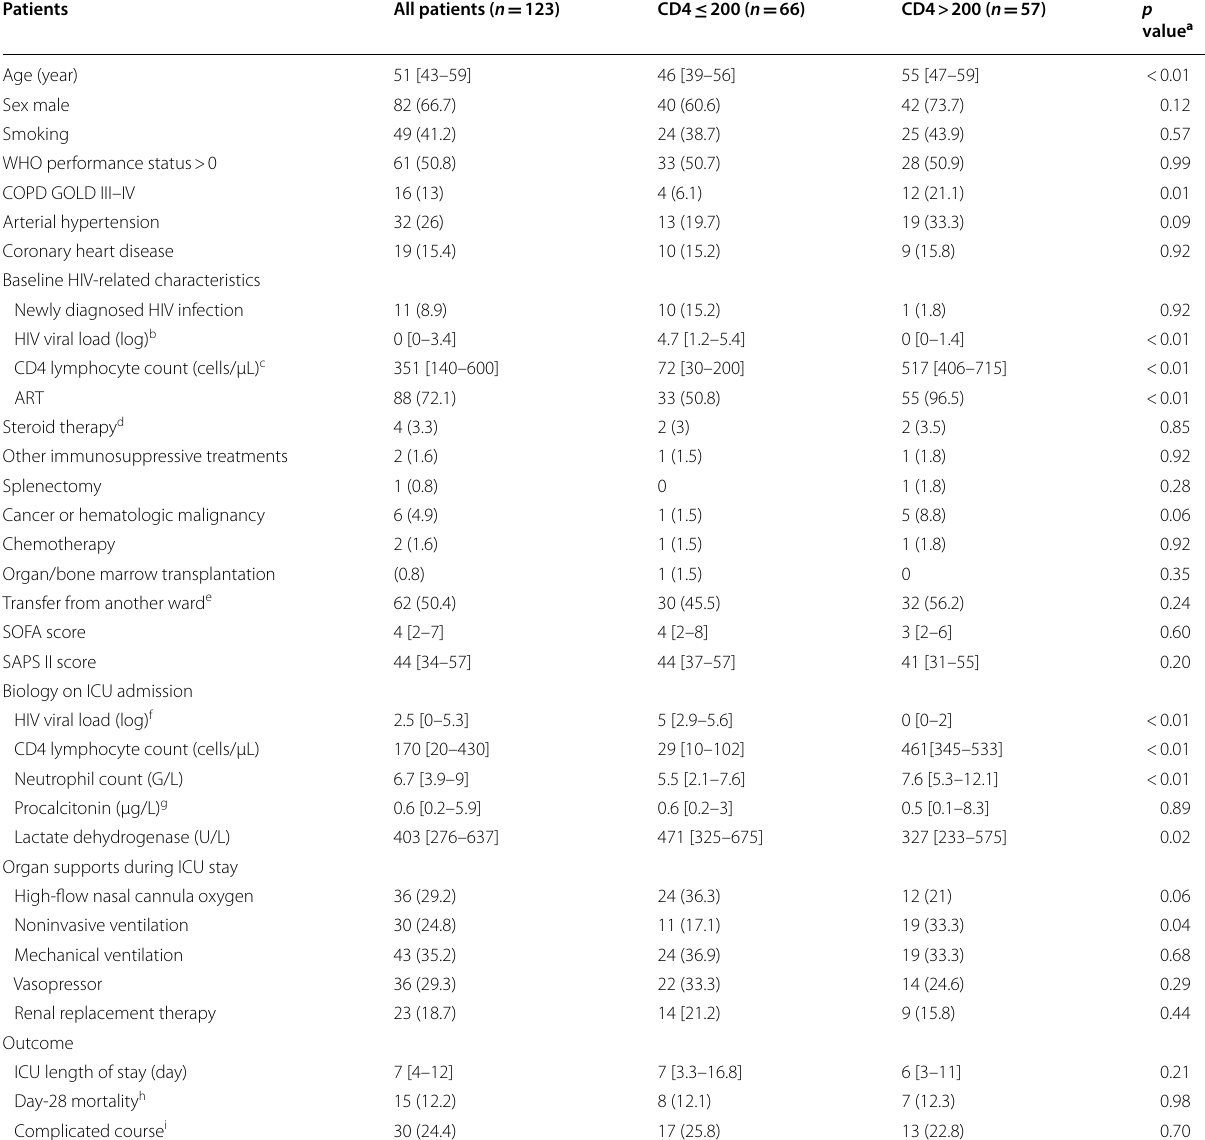
Table 1 Baseline characteristics, behavior during ICU stay, and outcome of 123 HIV-infected patients admitted to the